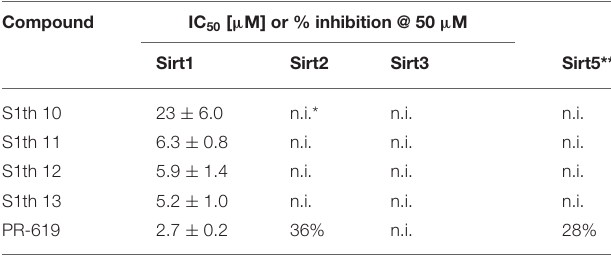
TABLE 3 | Inhibition of sirtuins 1, 2 3 and 5 by thiocyanate analgues of 4th round of virtual screening (S1th 10-13) and PR-619 . Compound